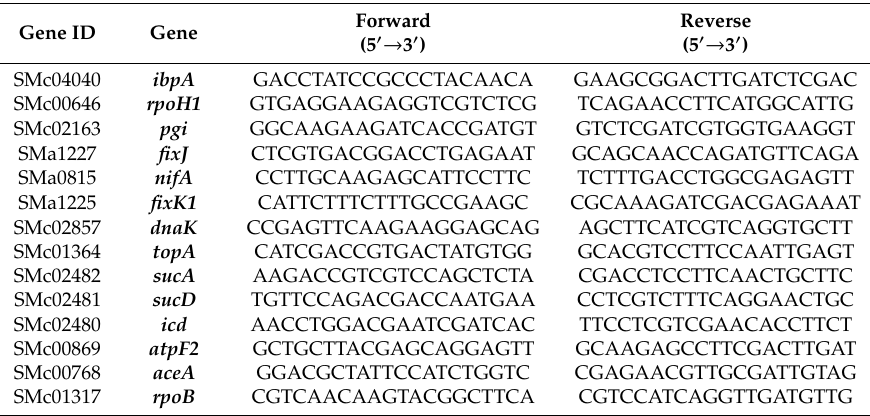
Table 1. Primers used in qRT-PCR